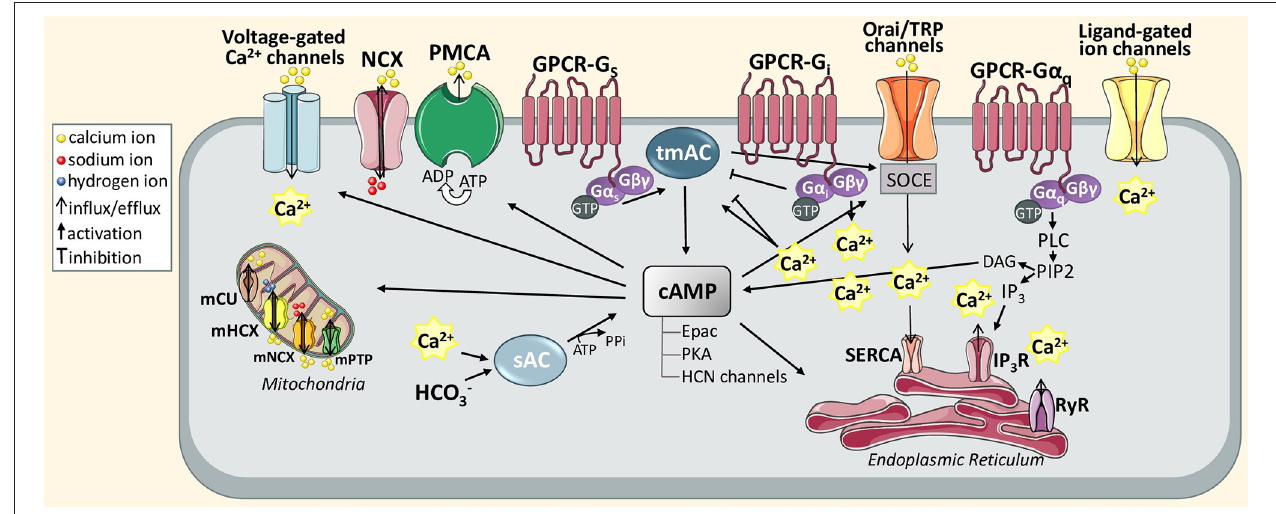
FIGURE 1 | Schematic diagram of astrocytic Ca 2 + and cAMP signaling pathways discussed in this review. The action of active GTP-bound G α i and GTP-bound G α o stimulates or inhibits transmembrane adenylyl cyclase (tmAC) that produces cAMP. The tmAC may also be controlled indirectly via store-operated Ca 2 + entry (SOCE). To maintain Ca 2 + homeostasis in the ER, SOCE is orchestrated through the interaction between store-operated plasma membrane calcium channels, called Orai or transient receptor potential (TRP) channel, and can stimulate SERCA pump activity once Ca 2 + levels fall below the threshold levels. In particular, this mechanism is generated when Ca 2 + stores in the ER are depleted upon activation of inositol 1,4,5-trisphosphate (IP3) receptor via G α q -phospholipase C (PLC)-IP3 signal transduction pathway. In turn, the DAG produced from PIP2 hydrolysis can also catalyze cAMP synthesis. Another activator of cAMP is Ca 2 + sensitive soluble adenylyl cyclase (sAC). cAMP itself and cAMP-dependent proteins (Epac PKA, and HCN channels) can differently transmit Ca 2 + signals supporting various astrocytic functions including gliotransmission, glycogen metabolism or synaptic